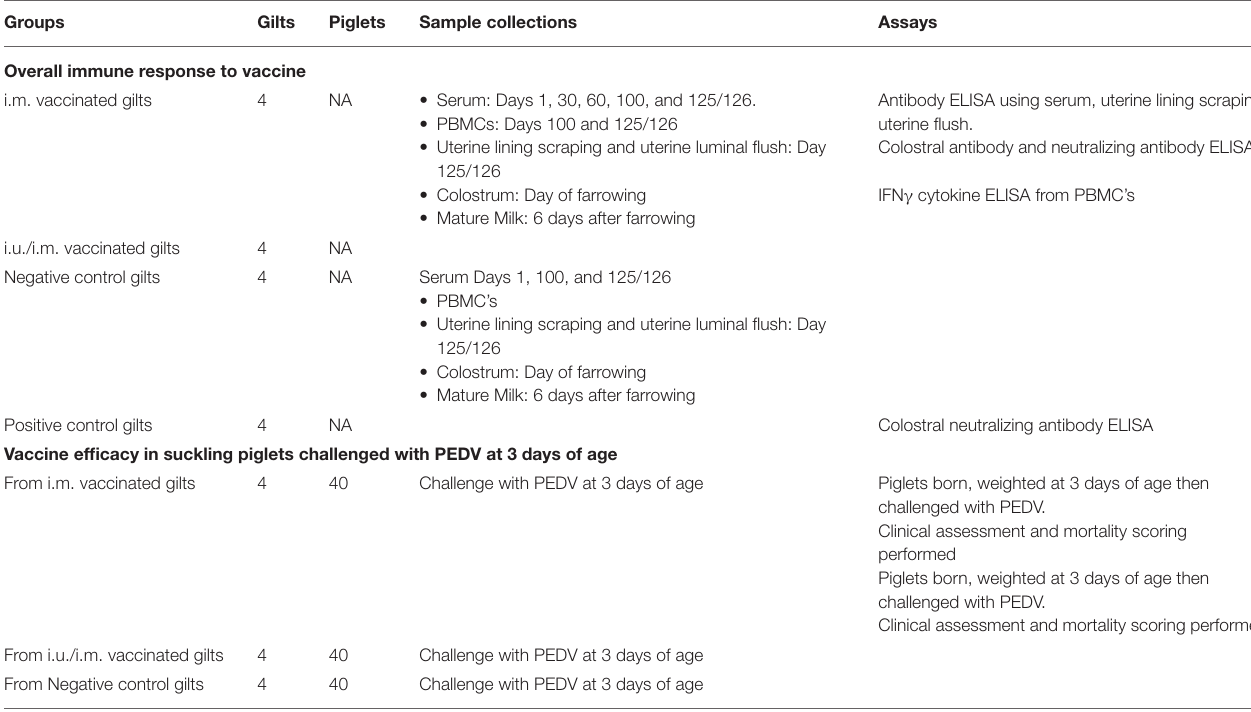
TABLE 3 | Listing of animal numbers, assays, and